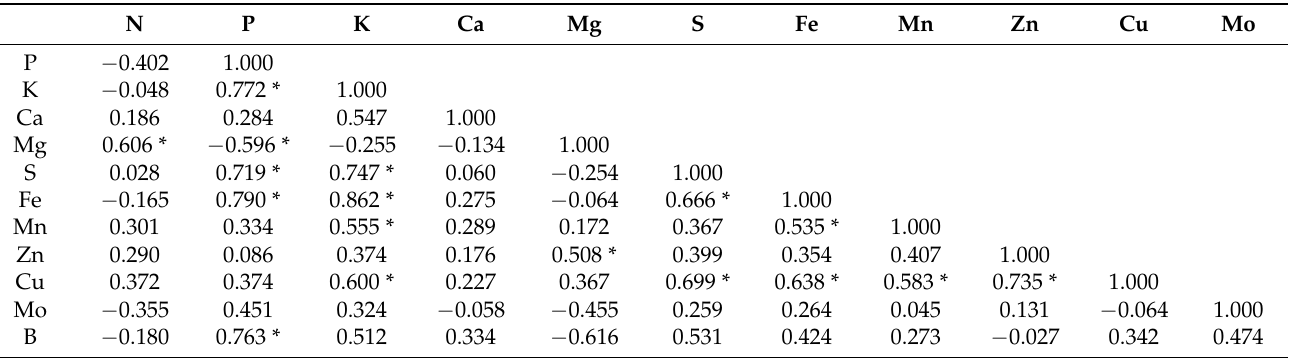
Table 4. Pearson’s correlation matrix between nutrient concentrations in older tomato leaves